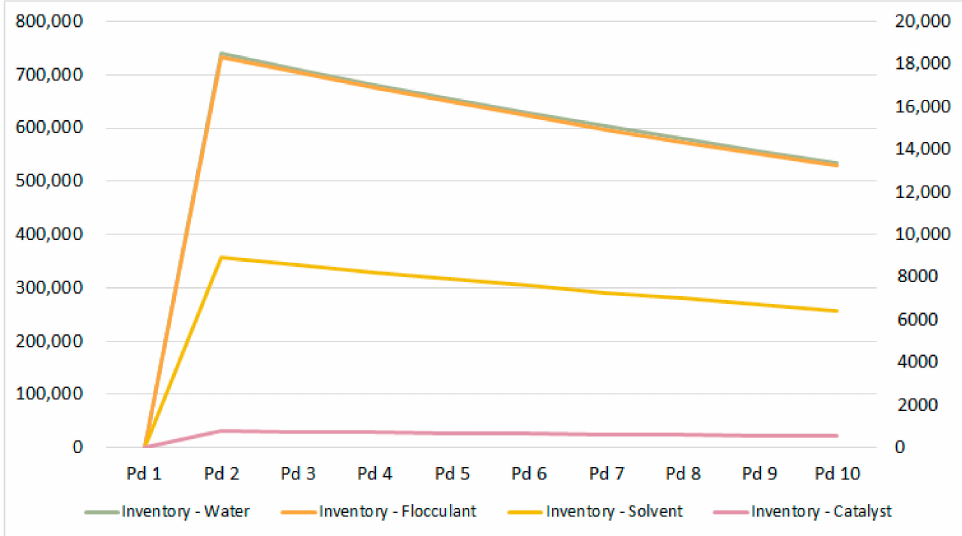
Figure 6. Behavior of inventory levels for each input material over